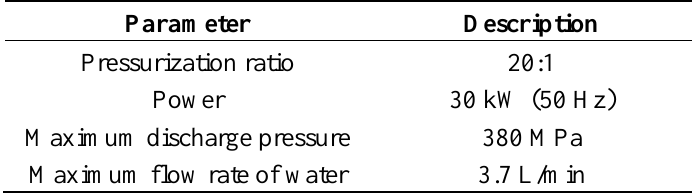
Table 1. Primary operating parameters of the ultra-high pressure